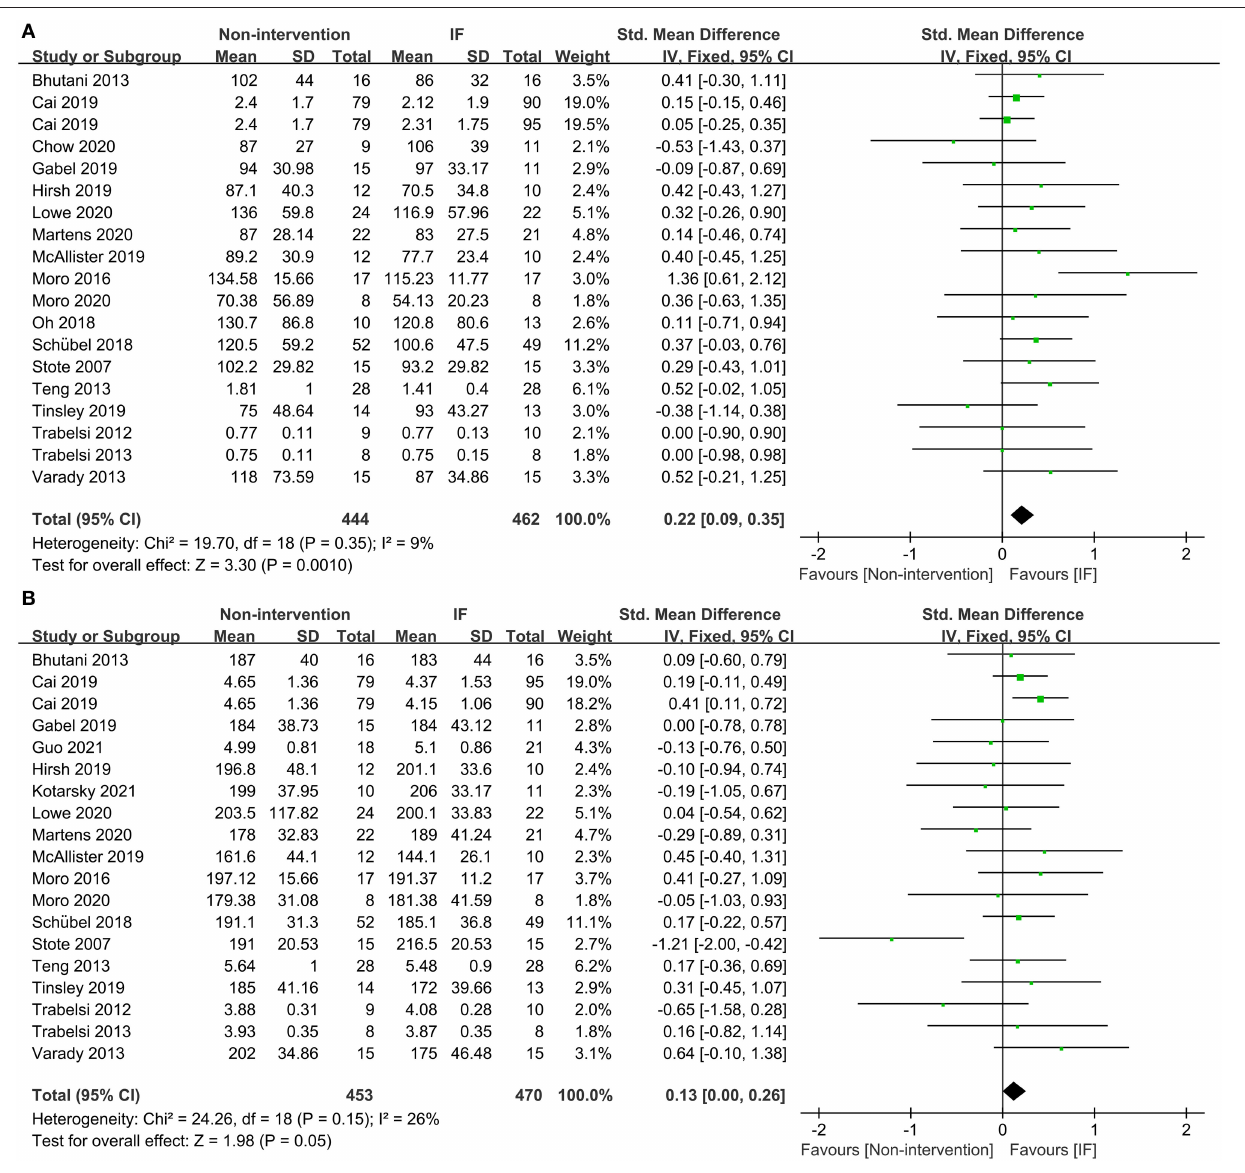
FIGURE 5 | Forest plots for the triglyceride (TG) and total cholesterol (TC) of IF vs. non-intervention diet. (A) TG; (B)